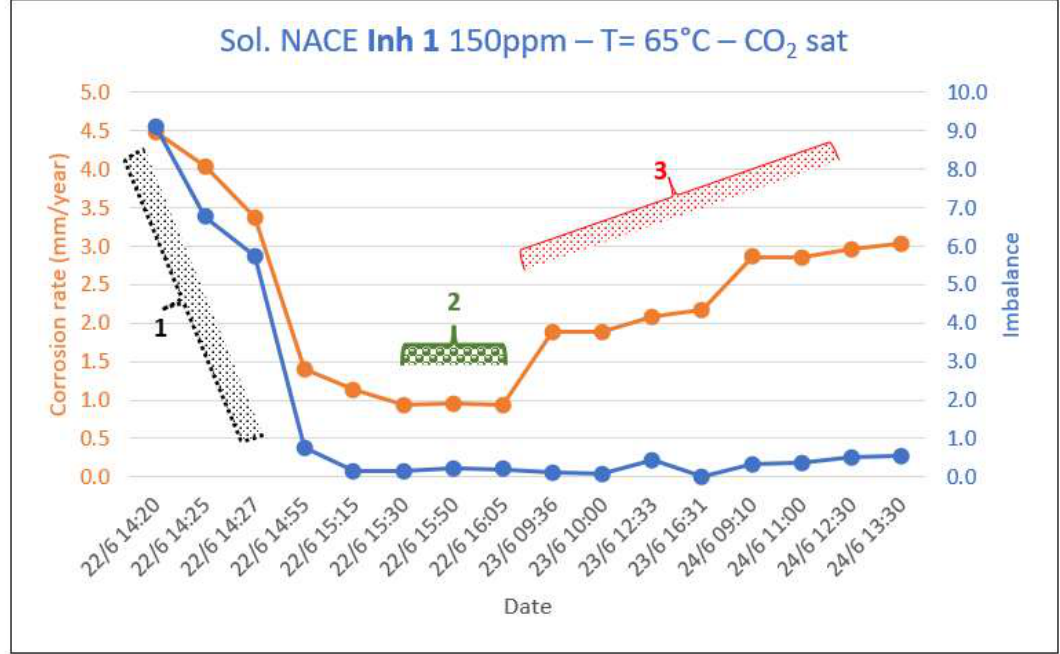
Figure 6. Different zones in which the inhibitor works. Zone 1: the time the inhibitor takes to coat the graduated cylinder and inhibit. Zone 2: the period during which the inhibitor works. Zone 3: the period in which the inhibitor stops working, and the corrosion rate increases.